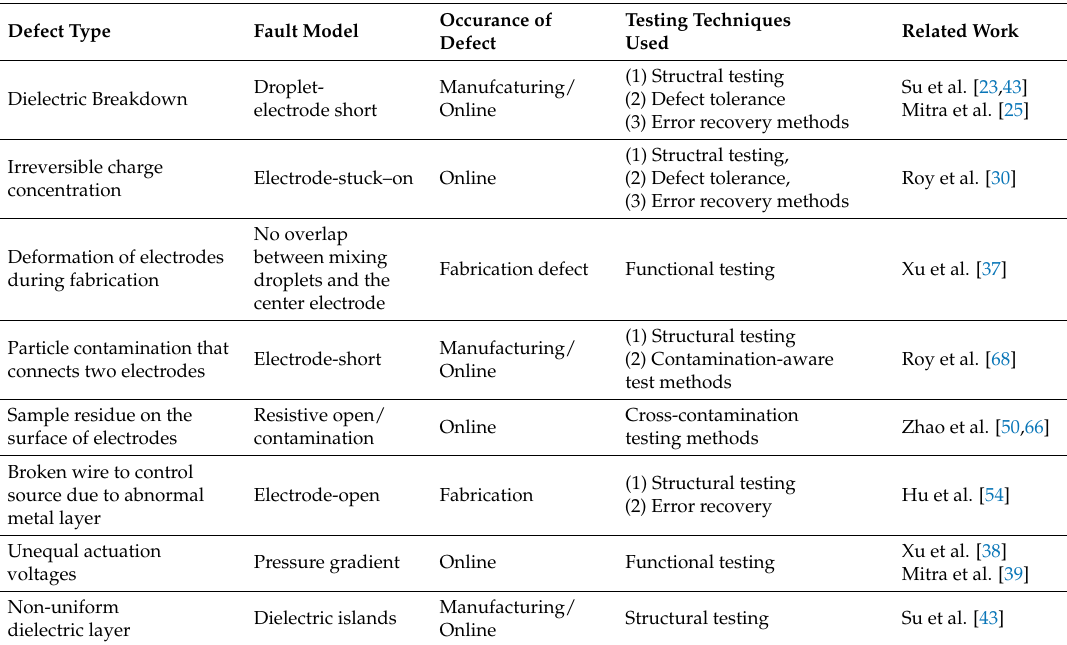
Table 1. Summary of testing techniques for